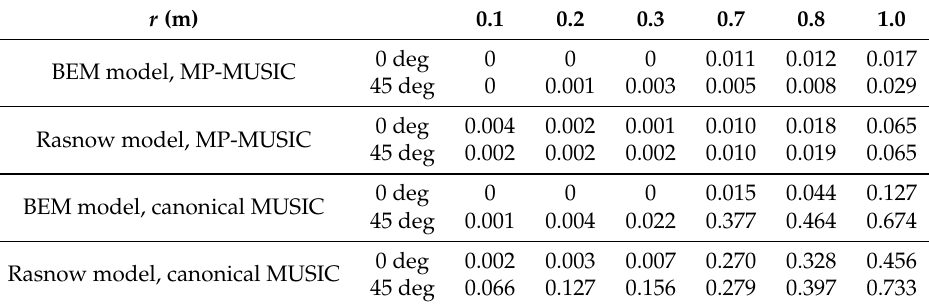
Figure 9. The schematic diagram of the electro-locator when the azimuths of the target are 0 deg and 45 deg. Table 3. The locating errors when the azimuths are 0 degrees and 45